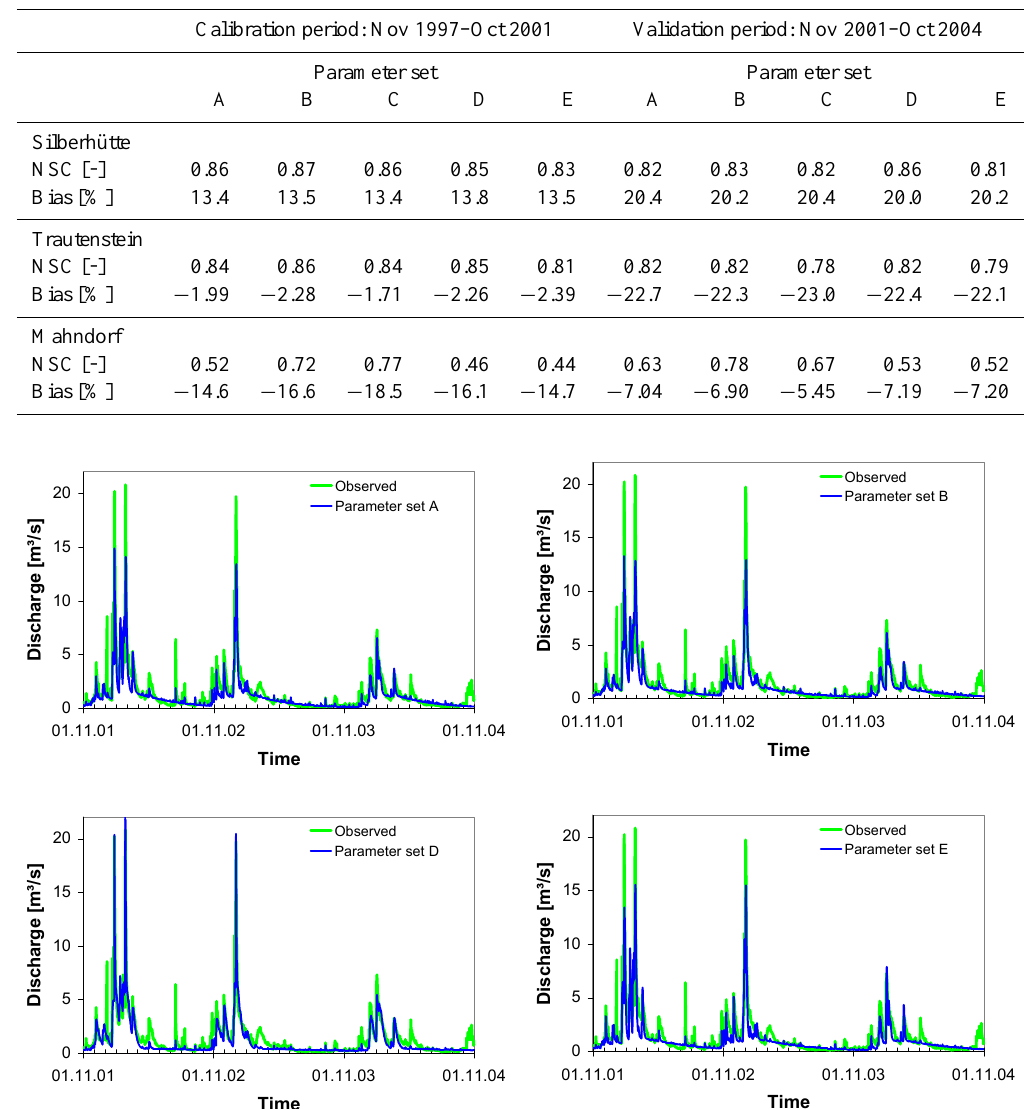
Fig. 8. Simulated hydrographs using four different parameter sets A, B, D and E based on observed hourly precipitation for the validation period from November 2001 to October